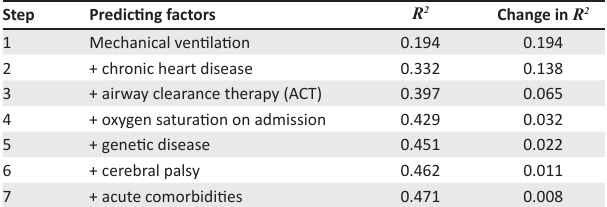
TABLE 5: Multiple regression outcomes for duration of hospitalisation. TABLE 4: Frequency of performed airway clearance therapies in the 83 cases